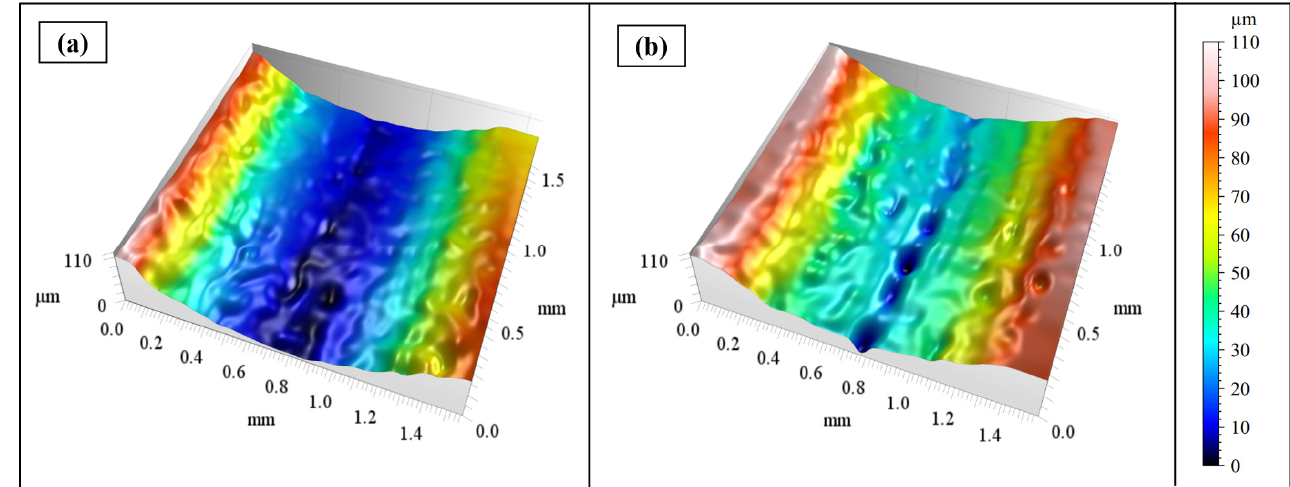
Figure 10. High resolution surface maps of ( a ) worn unpeened and shot-peened ( b ) samples at sliding distances of 300 m, showing decreases in width and depth of wear track after shot peening.